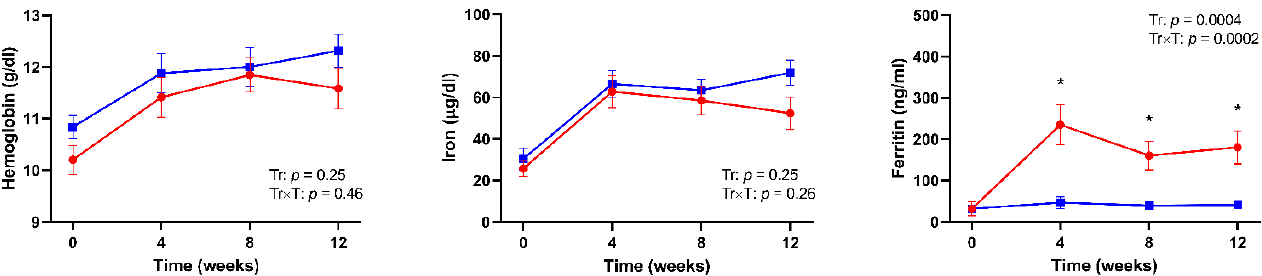
Figure 1. Time-trends of hemoglobin, serum iron, and serum ferritin levels in patients with ulcerative colitis (UC) treated with intravenous ferric carboxy-maltose (red lines) or oral sucrosomial ® iron (blue lines). p values for time (T) and treatment by time interaction (Tr × T) effects are shown.